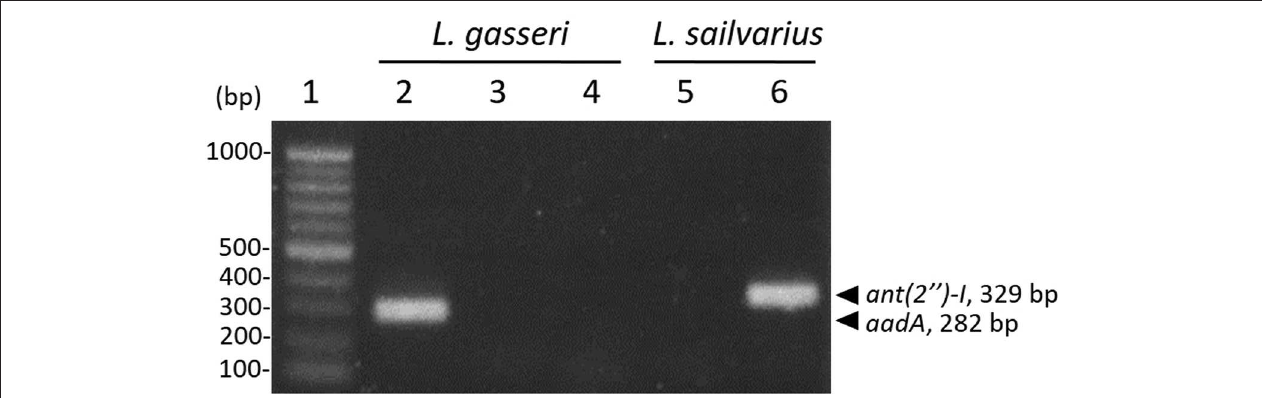
Frontiers in Veterinary Science |